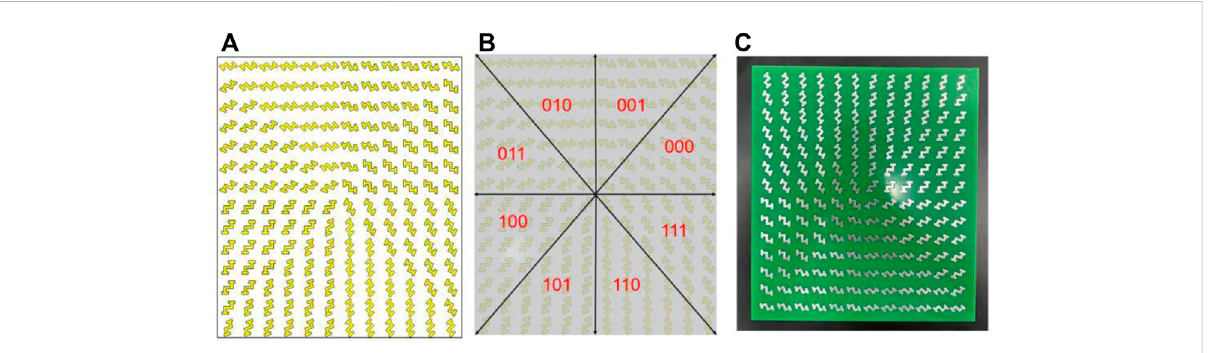
FIGURE 2 (A) The illustration of unit cell array pattern and (B) the coding arrangement of the metasurface; (C) the fabricated metasurface on the PCB.